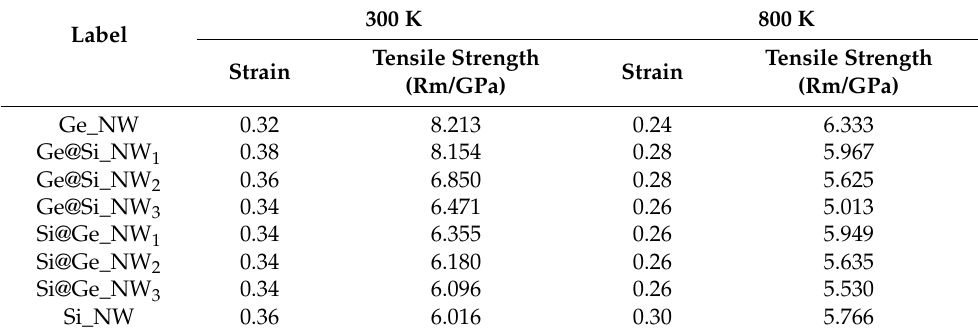
Table 3. Tensile strength of Ge@Si and Si@Ge nanowires with different core–shell ratios at 300 K and 800